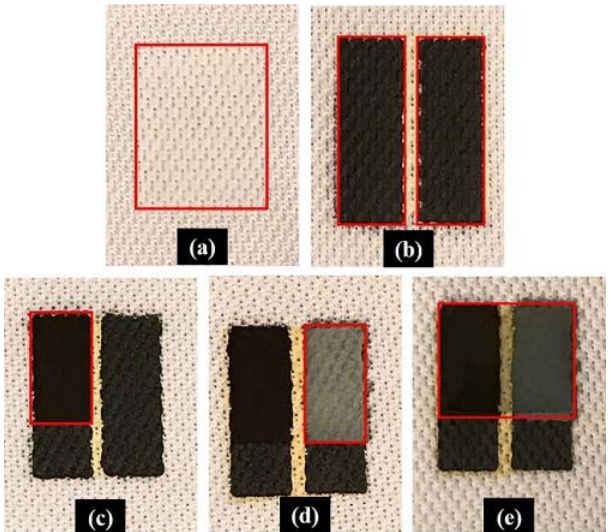
Figure 2. Printed ( a ) insulation layer, ( b ) carbon current collector layer, ( c ) silver oxide layer, ( d ) zinc layer, and ( e ) separator layer.